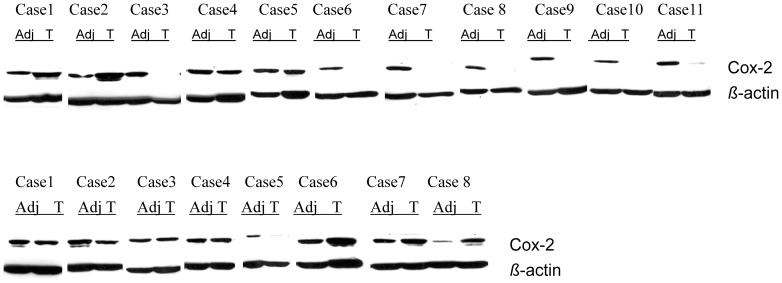
Example of representative cases analysed in this study showing Western blot of COX-2 in matched pairs of 11 noncirrhotic (upper panel) and 8 cirrhotic (lower panel) samples of HCC and tumor-adjacent liver parenchyma.(Adj: tumor-adjacent liver parenchyma; T: tumor (HCC)).